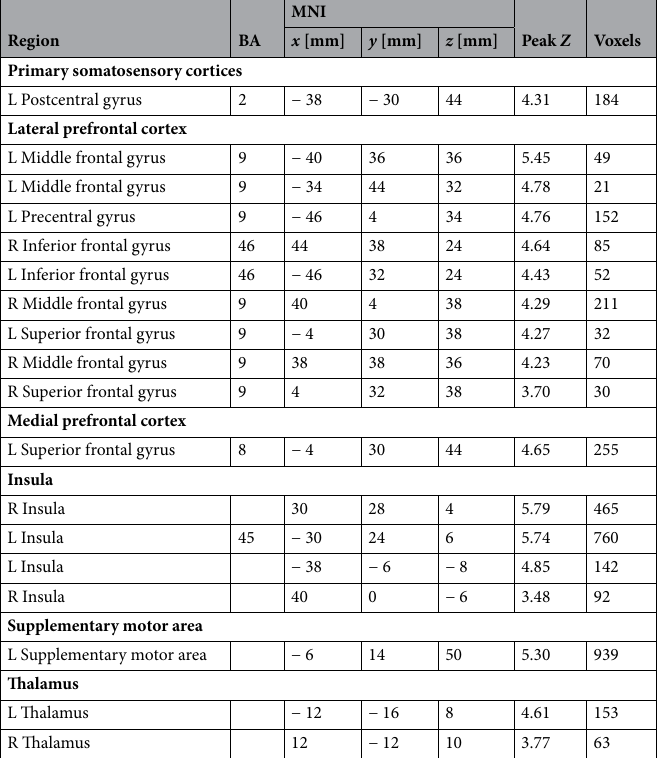
Table 5. MNI coordinates of the activated clusters in trial 5. In this trial, a stimulation current amplitude that was 0.5 times that of the standard amplitude was applied. Threshold values of uncorrected p and cluster extent k were set as smaller than 0.001 and more than 20, respectively. L left hemisphere; R right hemisphere.